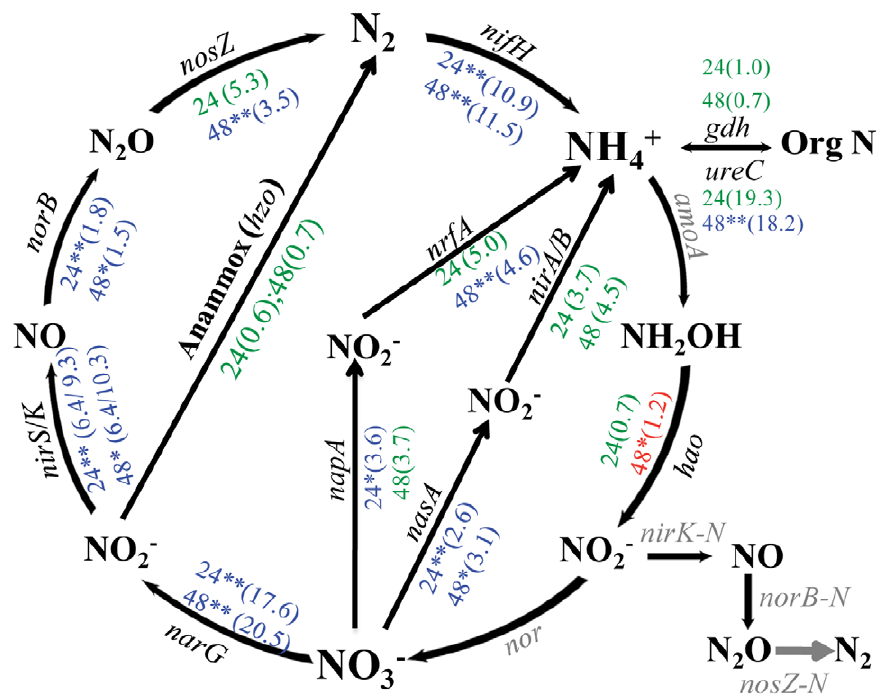
Figure 5 . The impact of EcO157 on genes involved in nitrogen cycling in biofilm communities. The relative abundance of each gene was normalized to the total hybridization signals of all detected genes involved in nitrogen cycling. Genes labeled in black were detected by GeoChip whereas genes labeled in grey were either not detected by hybridization or not present on the GeoChip. The number 24, and 48 represents the biofilms at 24 h and 48 h, respectively. The number in a bracket followed either 24 or 48 was the sum of signal intensities of all detected gene probes divided by the sum of signal intensities of the detected nitrogen cycle genes, and weighted by the fold change of the signal intensities for this gene in EcO157-inoculated biofilms (24-S or 48-S) compared with controls (24-C or 48-C). For the number color corresponding to each gene, red designates that this gene had higher signal intensity in EcO157-inoculated biofilms than in the control biofilms; blue illustrates that this gene had lower signal intensity in EcO157-inoculated biofilms than in the control biofilms; and green designates no significant change in gene abundance between the control- and the EcO157-inoculated biofilms. The significance is indicated by either *(t test, P , 0.1) or **(t test, P , 0.05).